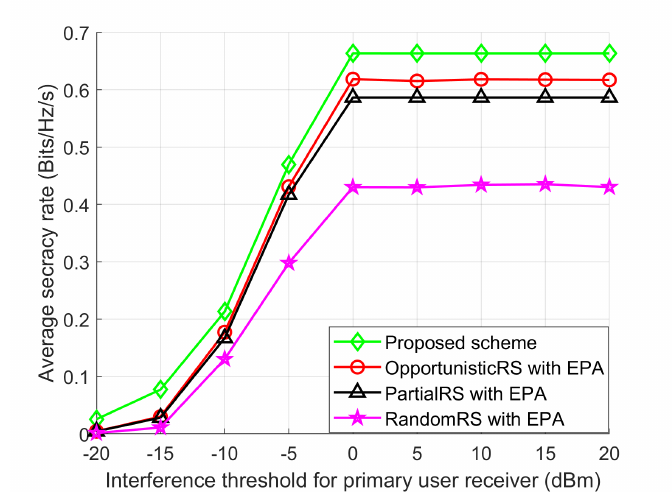
Figure 7. Average SR performance with I max